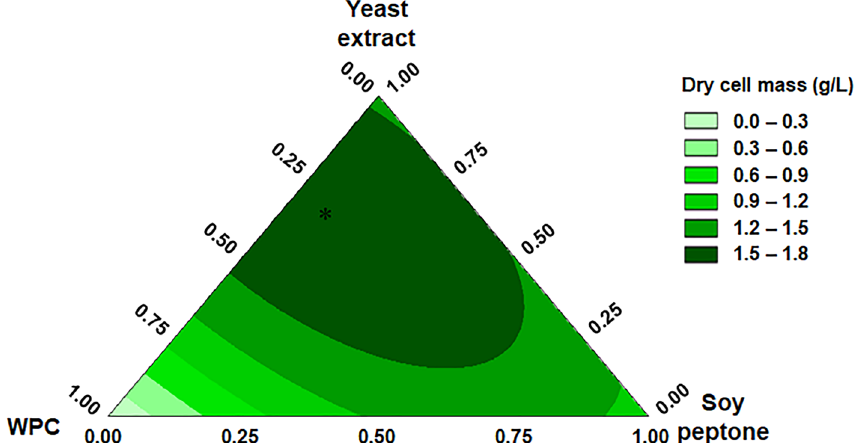
Figure 3. Mixture contour plots for biomass production of L. sakei ACU-2 showing the effect of the nitrogen sources. (*) Optimum estimated